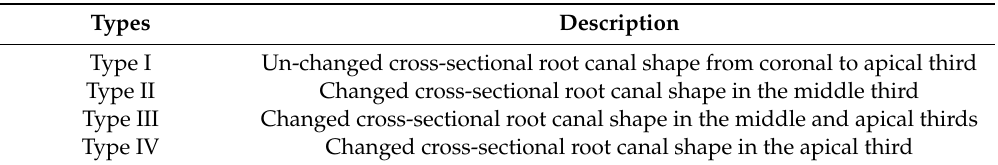
Table 2. Classification of changes of cross-sectional root canal